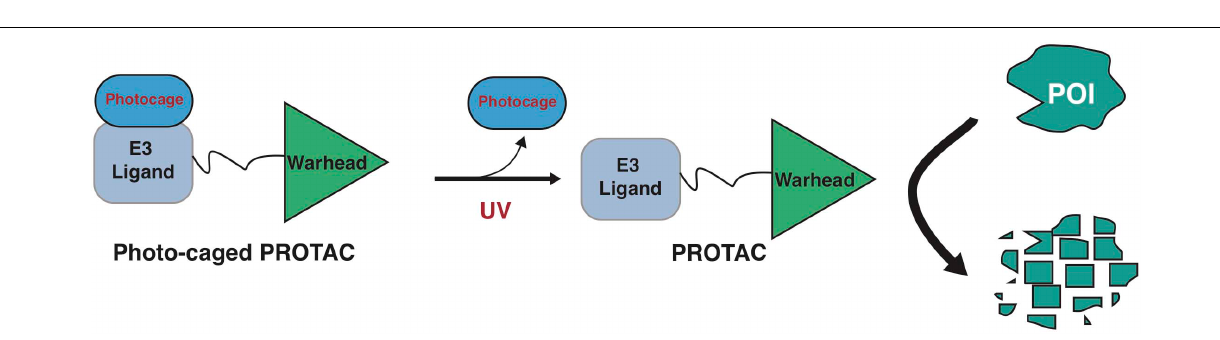
FIGURE 2 | A schematic diagram for action model of photo-caged-PROTAC under control of UV illumination. The photo-caged-PROTAC is inert at beginning and activated by UV illumination, which leads to the release of the photocage group, thus enabling the degradation of POI in a controllable